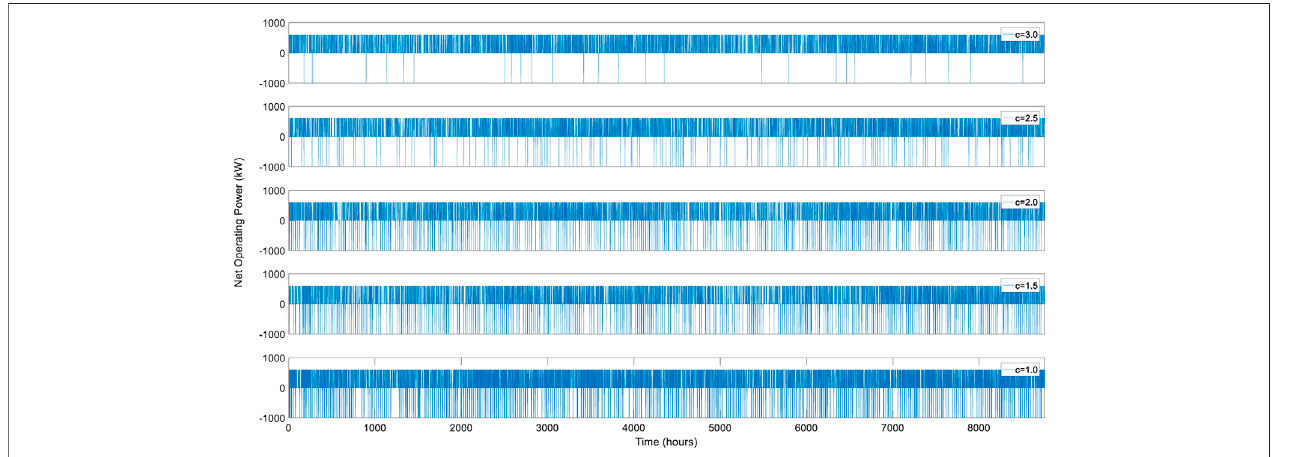
FIGURE 7 | The impact of the operation costs on decision-making in wind-power